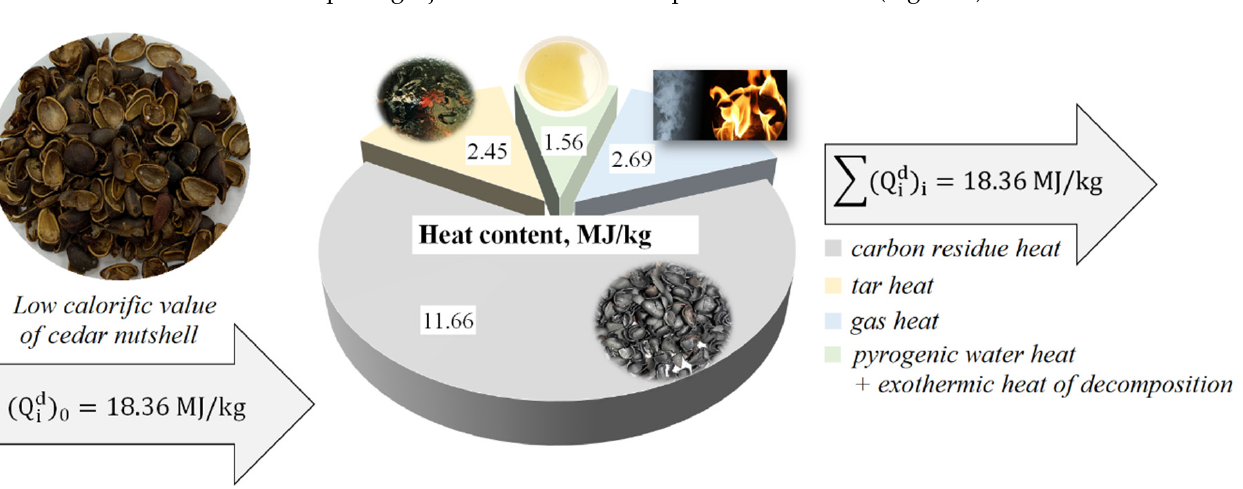
Figure 7. Thermal balance of Siberian pine nutshell pyrolysis.